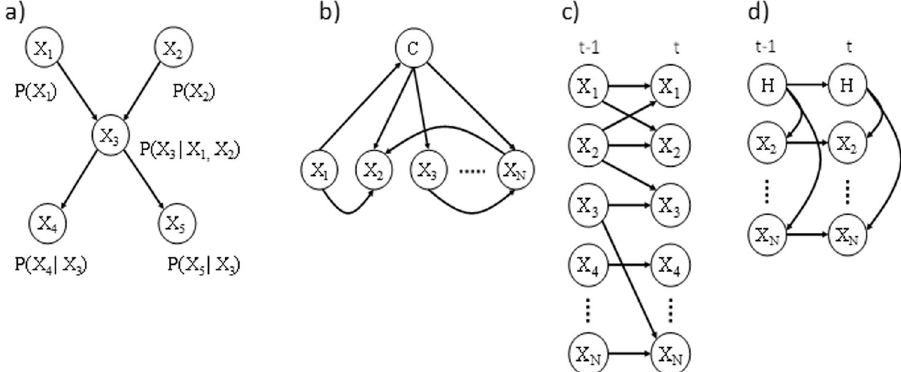
Fig. 5 Bayesian network architectures. a A Bayesian network with four nodes. b A Bayesian network classi fi er with class node C. c A dynamic Bayesian network with two time-slices, t and t − 1. d A Hidden Markov model with latent variable H